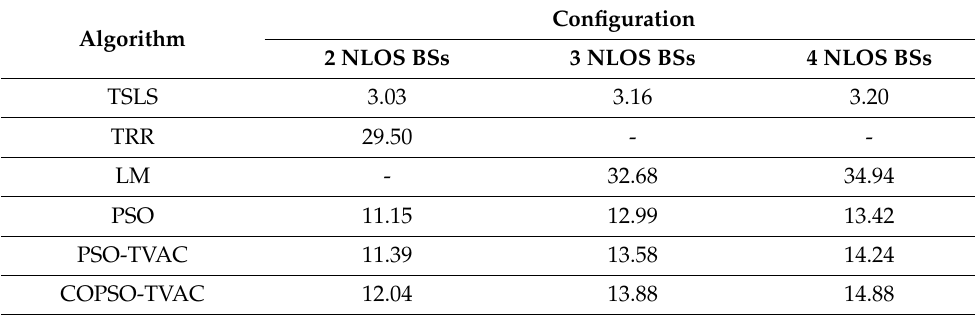
Table 5. Average computation times of the considered algorithms by different NLOS configurations, expressed in